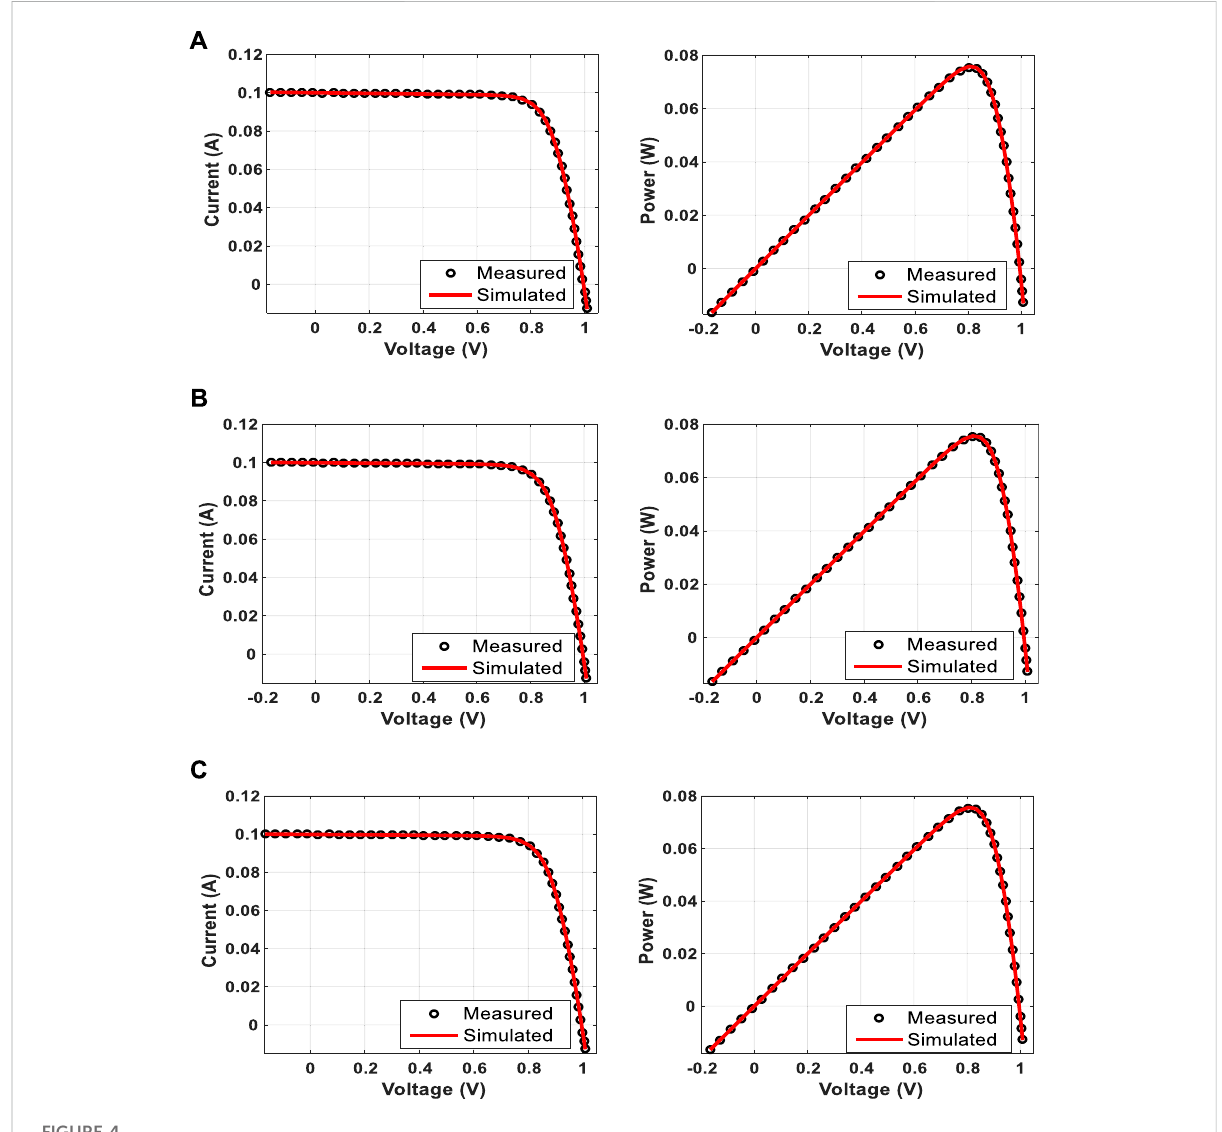
FIGURE 4 Measured and simulated I – V and P – V curves of the PVM752 cell. (A) SDM, (B) DDM, and (C)